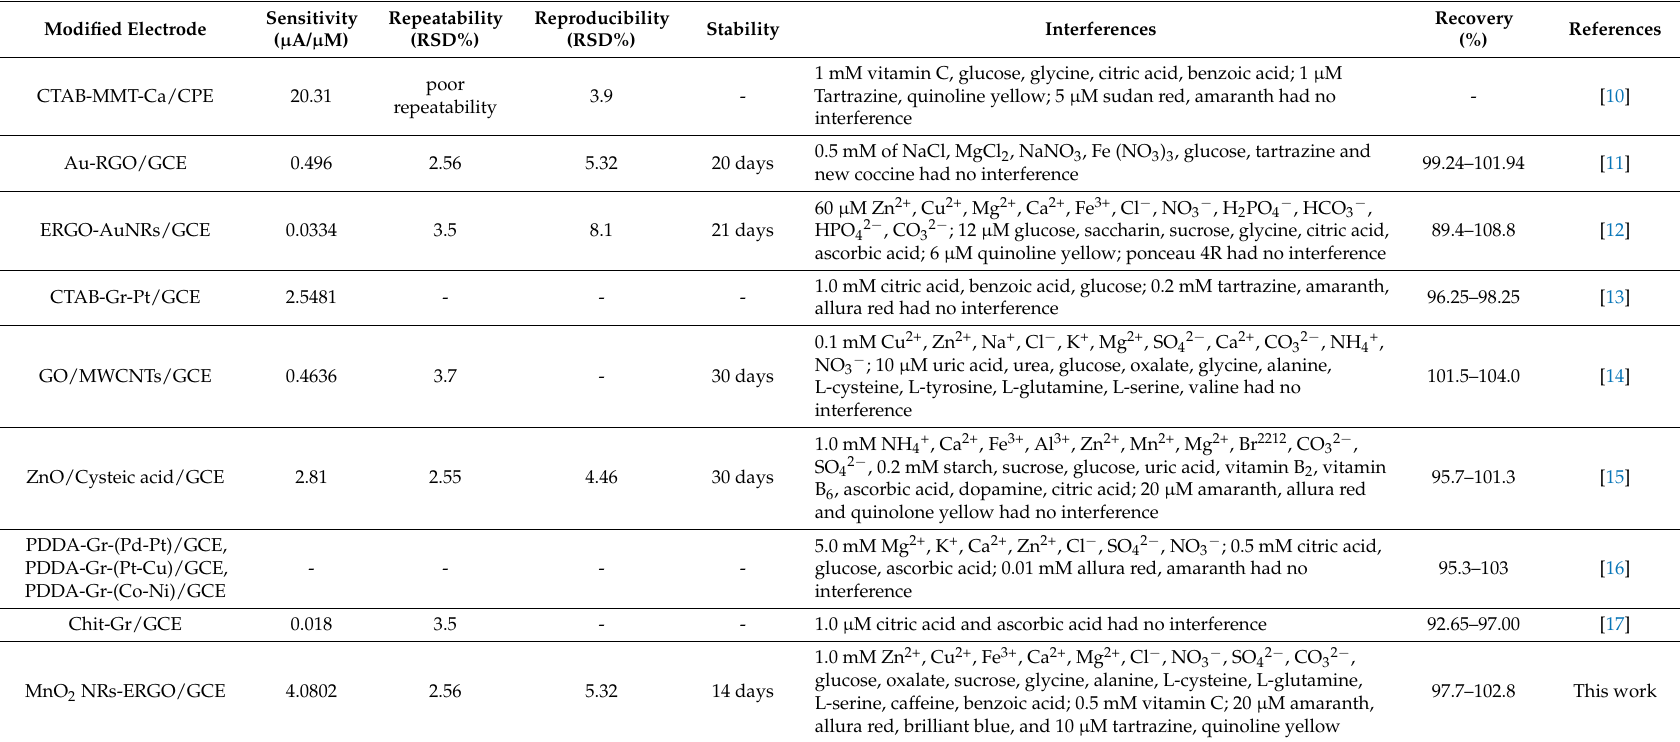
Table 1. Performance comparison of different modified electrodes for SY